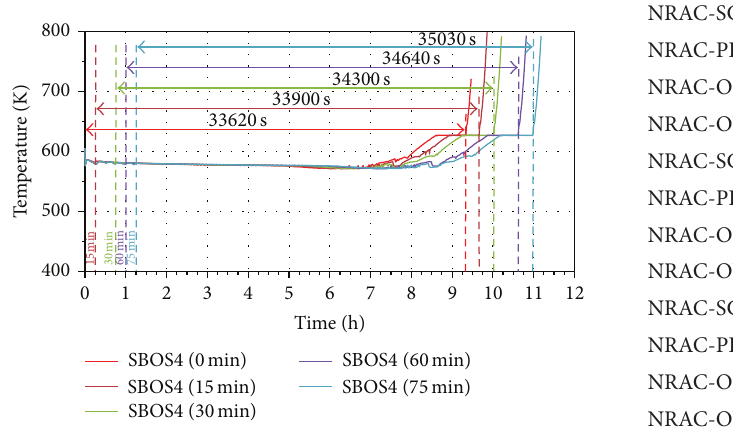
Figure 8: Average fuel cladding temperature at the top of the core, SBOS4 case scenarios. Table 5: Time to core heatup after stop of the TD AFW.